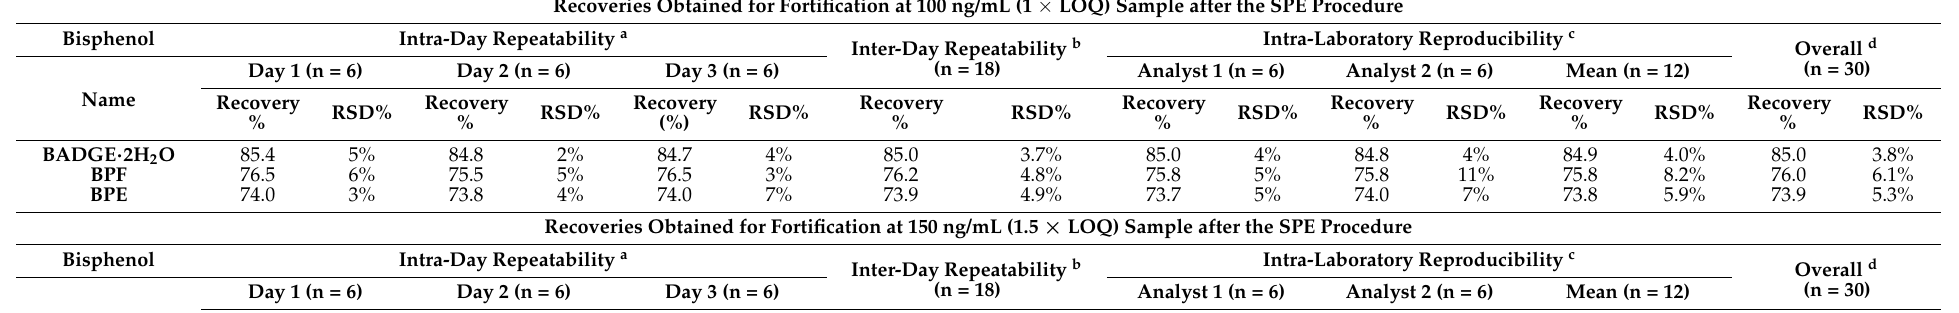
Table 4. Mean recoveries (%) and relative standard deviations expressed as a percentage (RSD%) for mixture of bisphenols extracted by SPE using Strata Phenyl SPE column. Recoveries Obtained for Fortification at 100 ng/mL (1 × LOQ) Sample after the SPE